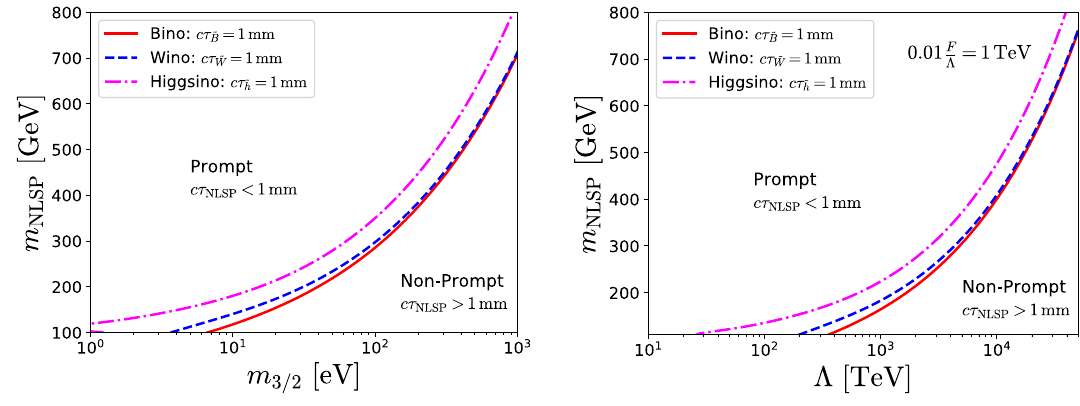
Figure 1 . Left: cτ = 1 mm contours in the m vs. m plane. Right: cτ = 1 mm contours in 3 / 2 ˜ χ 0 1 ˜ χ 0 1 (cid:31) χ 0 1 plane assuming 0 . 01 F the Λ vs. m = m = 1 TeV. In both plots, the red-solid, blue-dashed SUSY Λ (cid:31) χ 0 1 and pink-dot-dashed curves correspond to the bino, wino and higgsino NLSPs, respectively. The regions above the contours satisfy the assumption that the NLSP neutralino decays promptly into a gravitino, cτ < 1 mm. In the lower right region, the NSLP is long-lived and our analysis may ˜ χ 0 1 not be